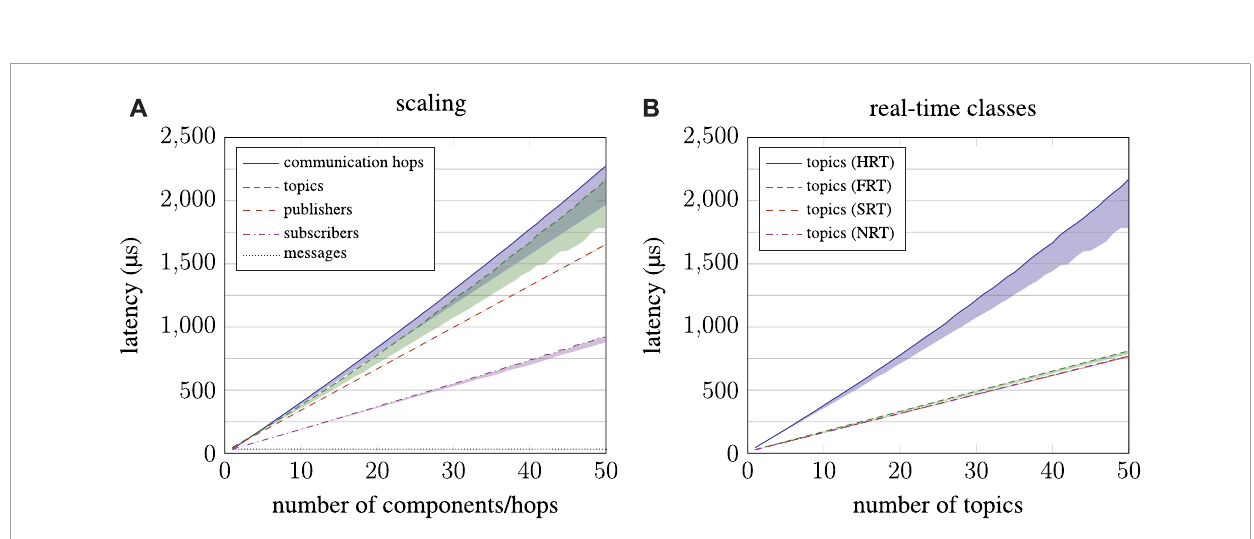
FIGURE 7 In-depth performance analysis of the publish–subscribe subsystem. On the left-hand side (A) , performance scaling when increasing the number of components in a system is depicted. On the right-hand side (B) , the performance of the four real-time classes is compared for increasing number of